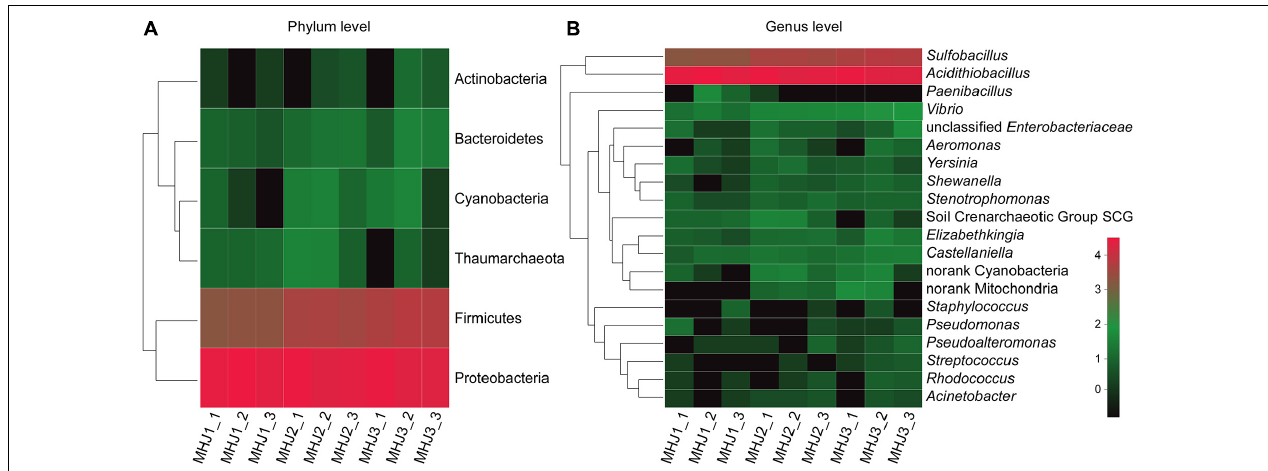
FIGURE 4 | Heatmap of microbial communities of MHJ at (A) phylum and (B) genus levels. MHJ1_1, MHJ1_2 and MHJ1_3, MHJ2_1, MHJ2_2 and MHJ2_3, MHJ3_1, MHJ3_2 and MHJ3_3 were the triplicates of samples MHJ1, MHJ2, and MHJ3, respectively.